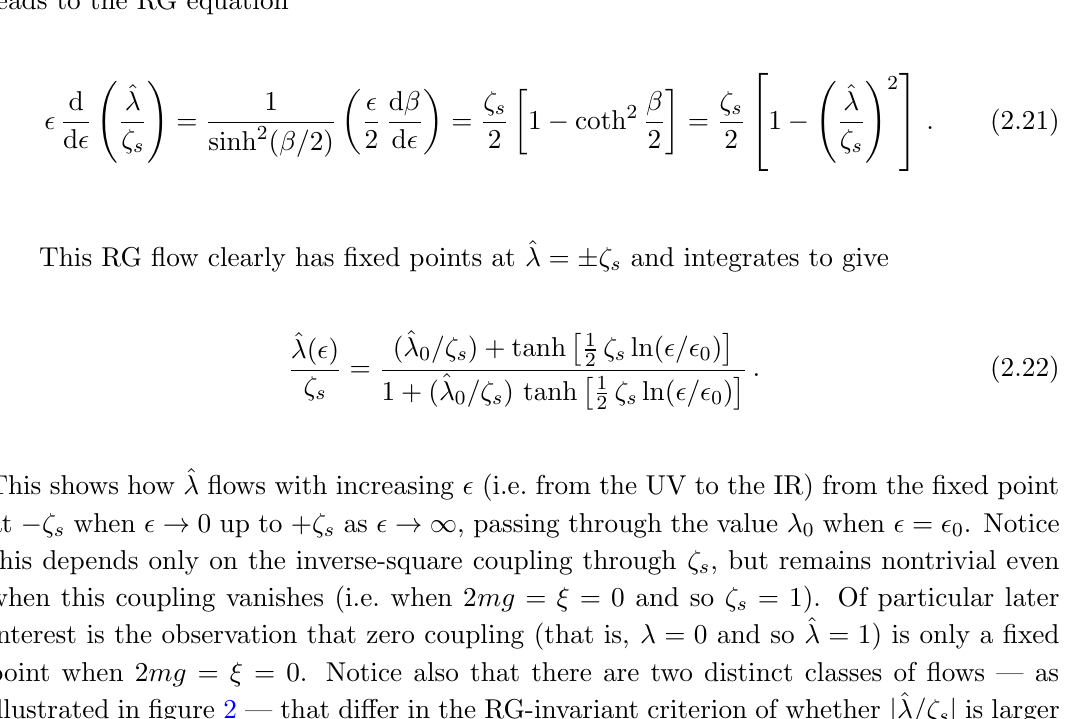
Figure 2 . Plot of the RG (cid:13)ow of ^ (cid:21)=(cid:16) s vs ln (cid:15)=(cid:15) ? where ^ (cid:21) = ( (cid:21)= 2 (cid:25)(cid:15) ) + 1 and with (cid:0) 3 chosen so that (cid:16) s is real. A representative of each of the two RG-invariant classes of (cid:13)ows is shown, and (cid:15) ? is chosen as the place where ^ (cid:21) = 0 or ^ (cid:21) ! 1 , depending on which class of (cid:13)ows is of